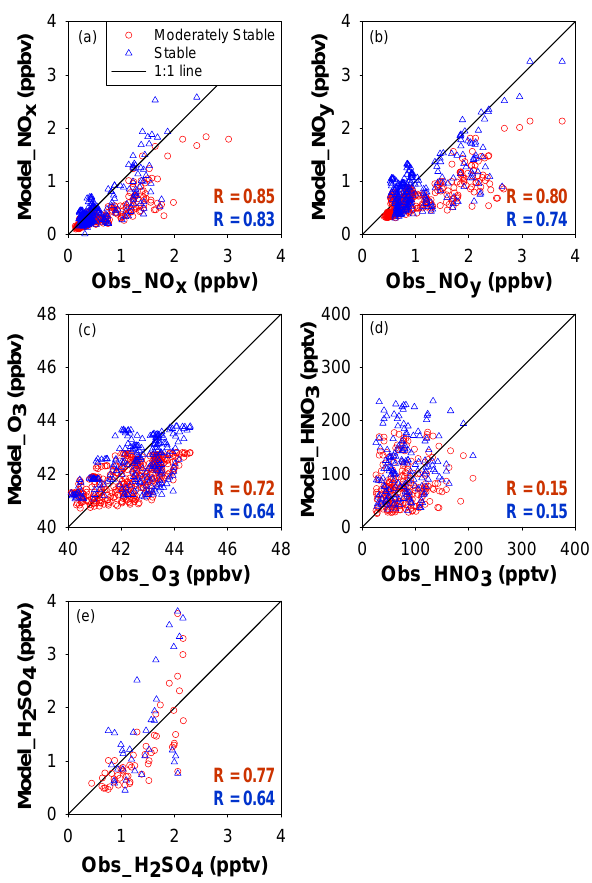
Fig. 9. Scatter plots of observed and model-predicted ship-plume concentrations: (a) NO x ; (b) NO y ; (c) ozone; (d) HNO 3 ; (e) H 2 SO 4 . The red circles and blue triangles represent the concen- trations predicted by the photochemical/dynamic ship-plume model under moderately stable and stable conditions,